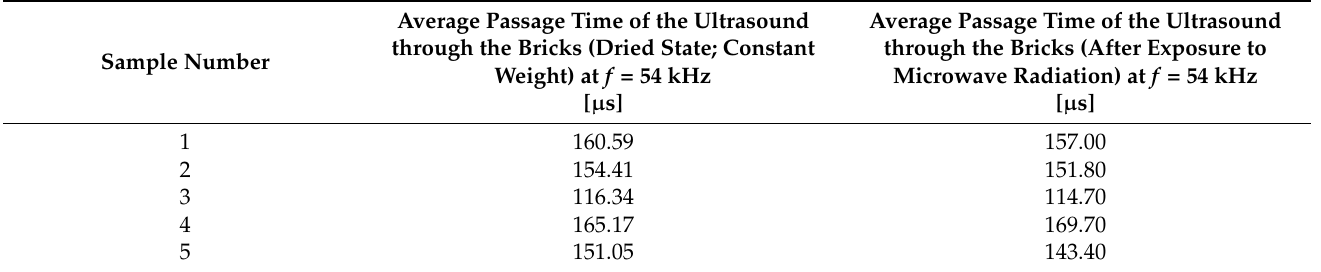
Sample Table 5. Overview of the average passage time of the ultrasonic wave.